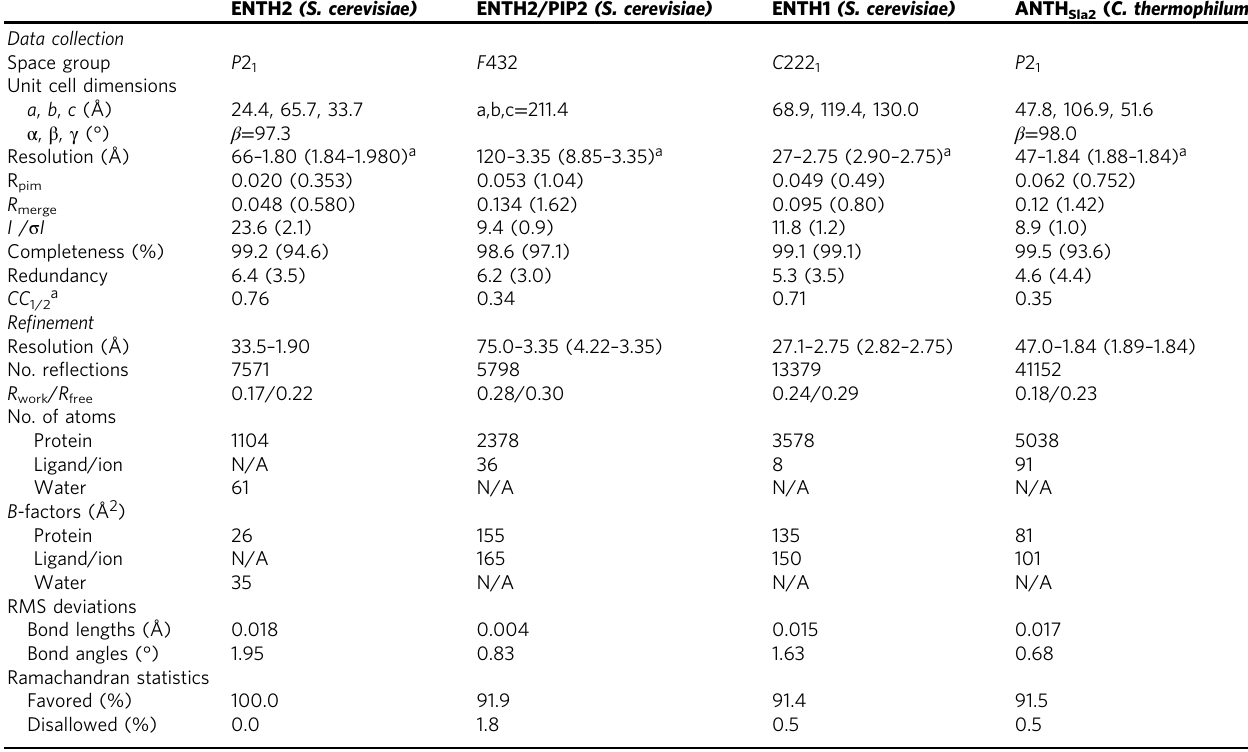
Table 1 Data collection and re fi nement